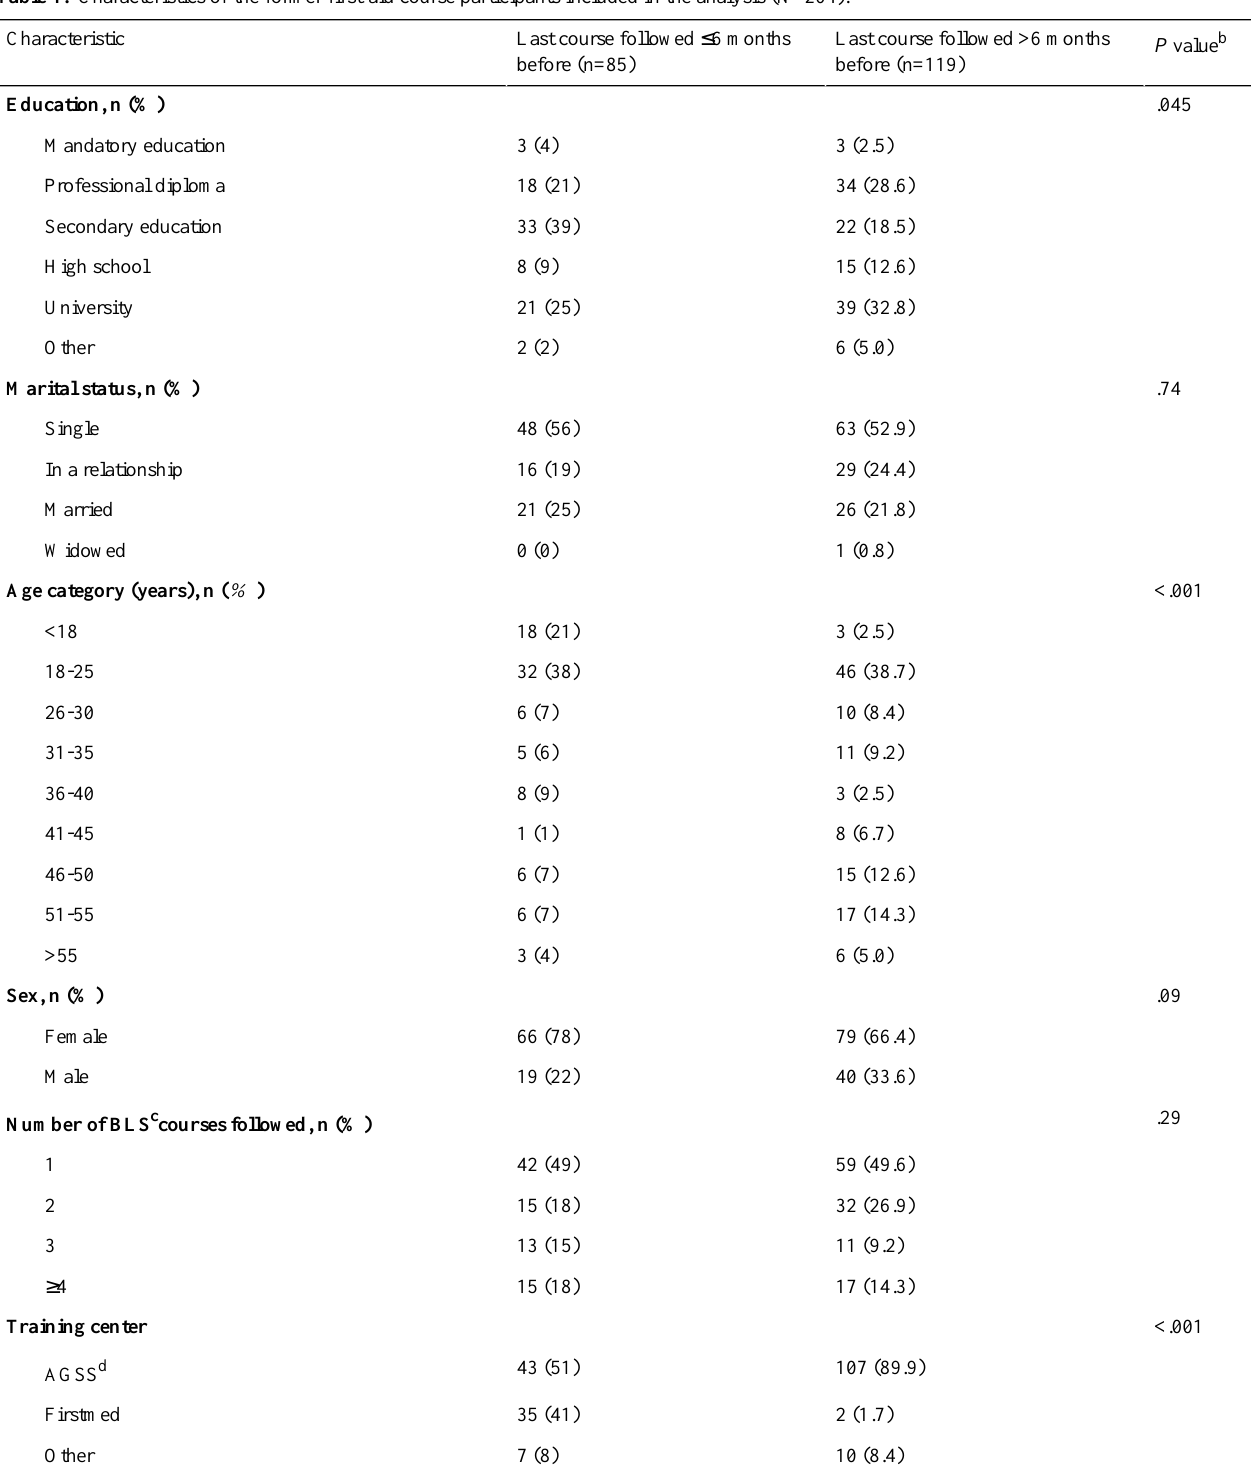
Table 1. Characteristics of the former first-aid course participants included in the analysis (N=204).